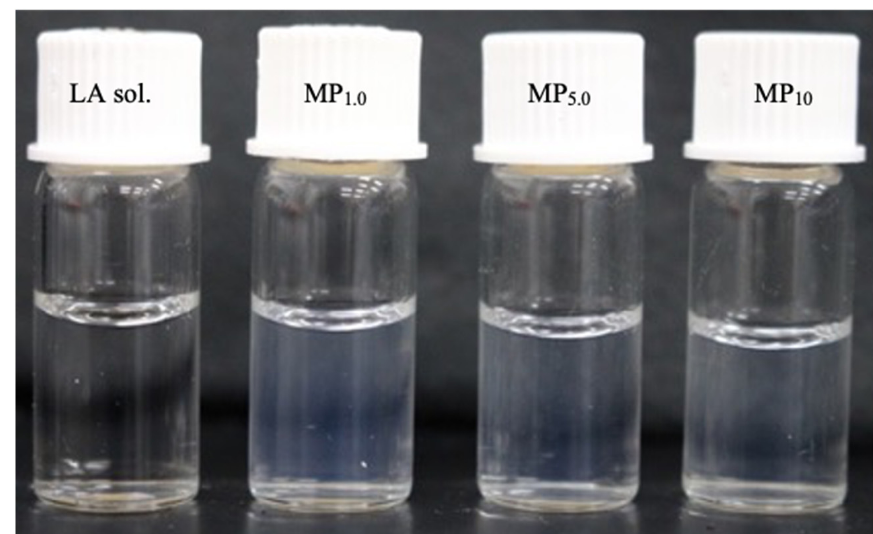
Figure 2. Visible observations of prepared formulations with the naked eye.